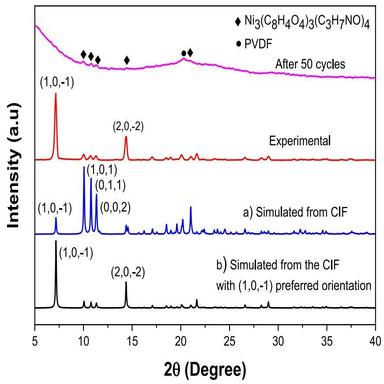
Powder X-ray diffraction pattern of the powder Ni3(C8H4O4)3(C3H7NO)4 (red) and after 50 cycles (magenta). The blue line (a) represents the pattern simulated from the CIF, the black line (b) represents the pattern simulated from the CIF with (1,0,−1) orientation and Marchdollase 0.43476.